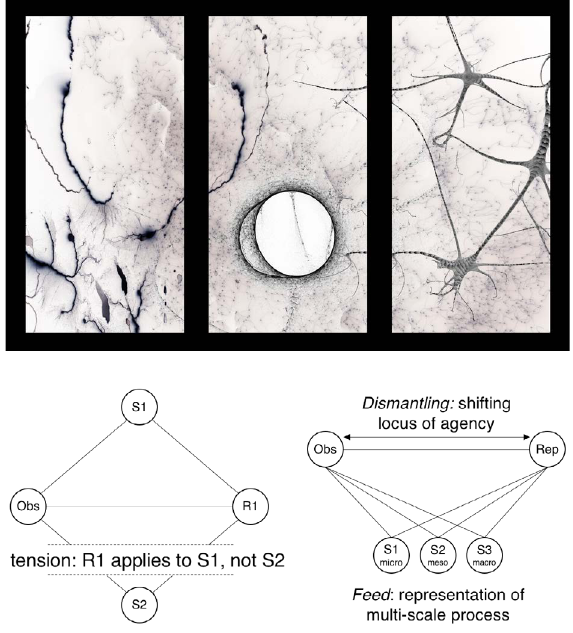
Figure 4. Whereas Dismantling explored the shifting locus of agency between the observer and the representation, Feed requires representation of a multi-scale process in a cohering representation (a, mockup). Engaging with an unfamiliar system with a familiar representation (reusing code or interface) may introduce epistemological tension that must be resolved